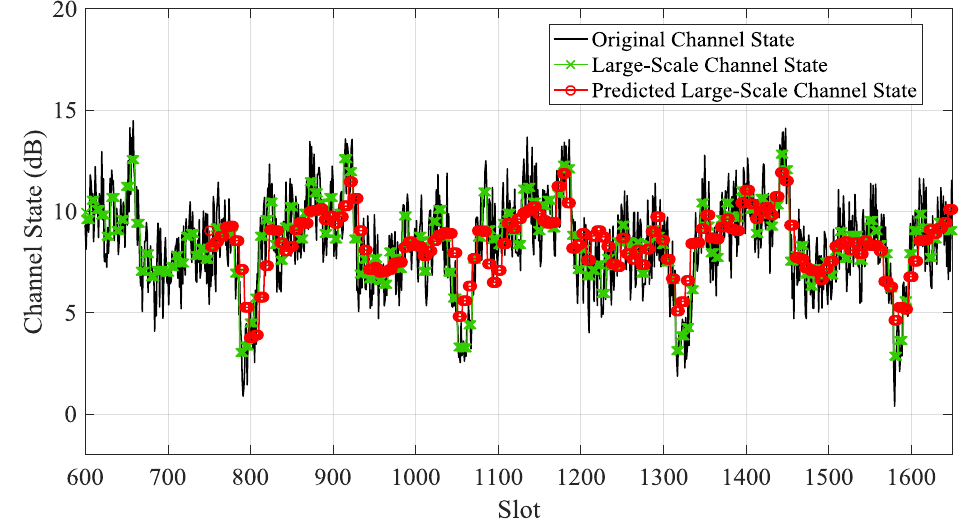
Figure 13. Predicted large-scale channel state and real large-scale channel state of Data